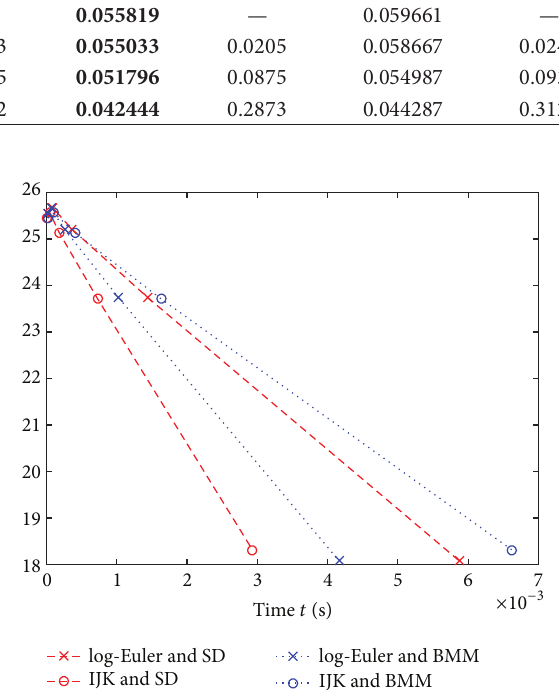
Figure 3: Strong convergence error of the financial underlying process (𝑆 𝑡 ) , as a function of CPU time (in sec) using log- Euler or IJK method with SD or BMM scheme for (1) with ,𝑆 ,𝜇,𝑘 , 𝑘 ,𝑘 , 𝑞,𝑇) = (1/16,100, 0.05, 1/16,1, 0.4,3/4, 1) , cor- (𝑥 0 0 1 2 3 relation 𝜌 = −0.8